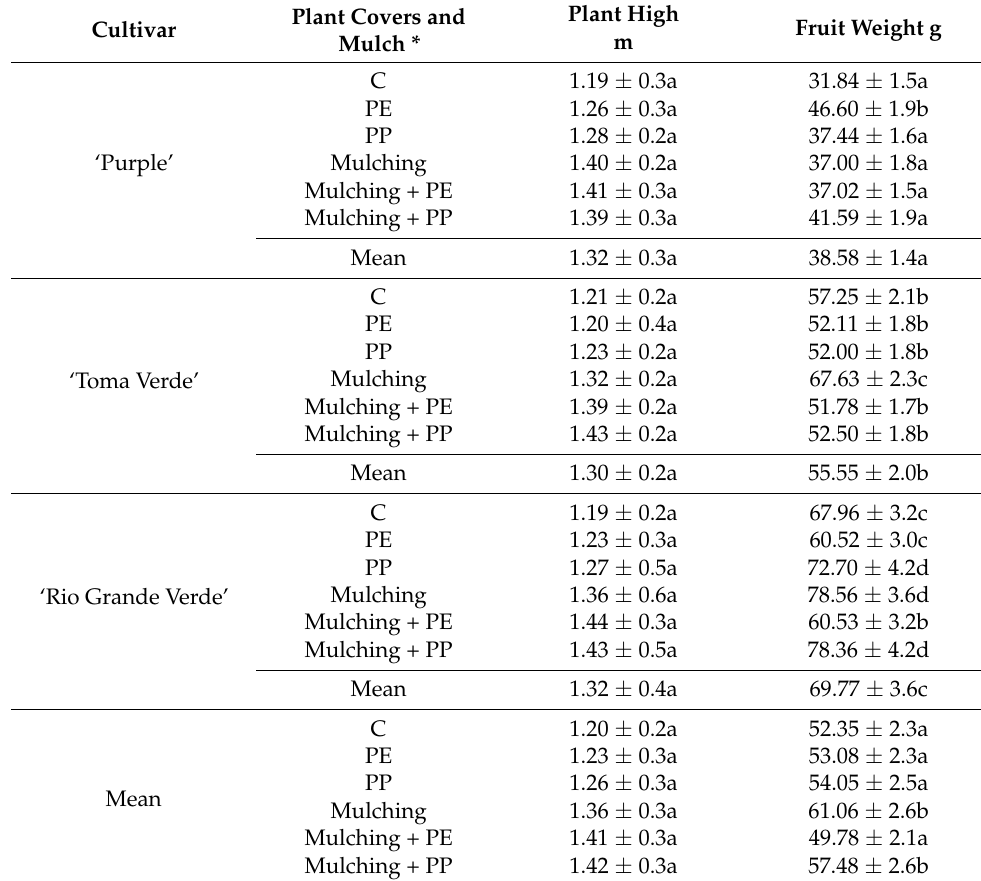
Table 9. The effects of cultivar, plant covers andmulching on the biometric parameters of tomatillo plants (means of 2015, 2017–2018).